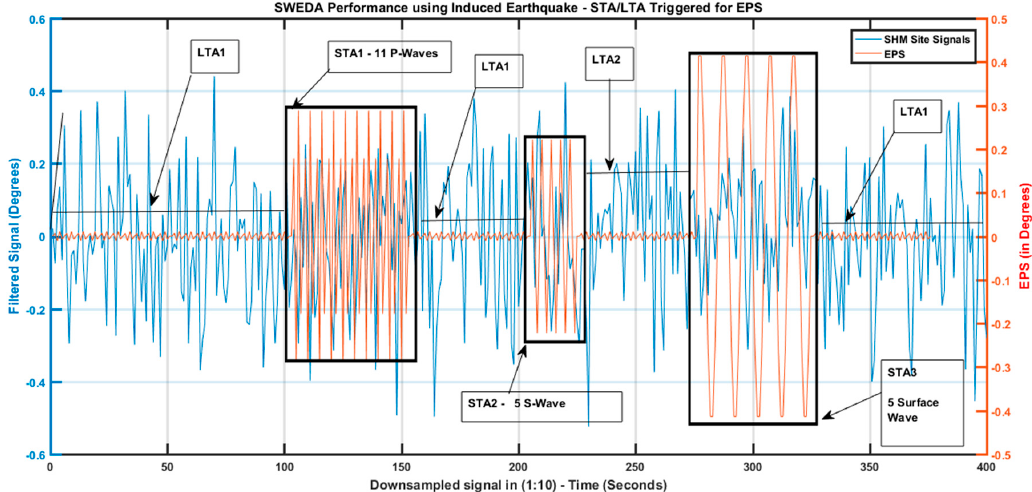
Figure 26. EPS for the assumed dataset (down-sampled to 400).